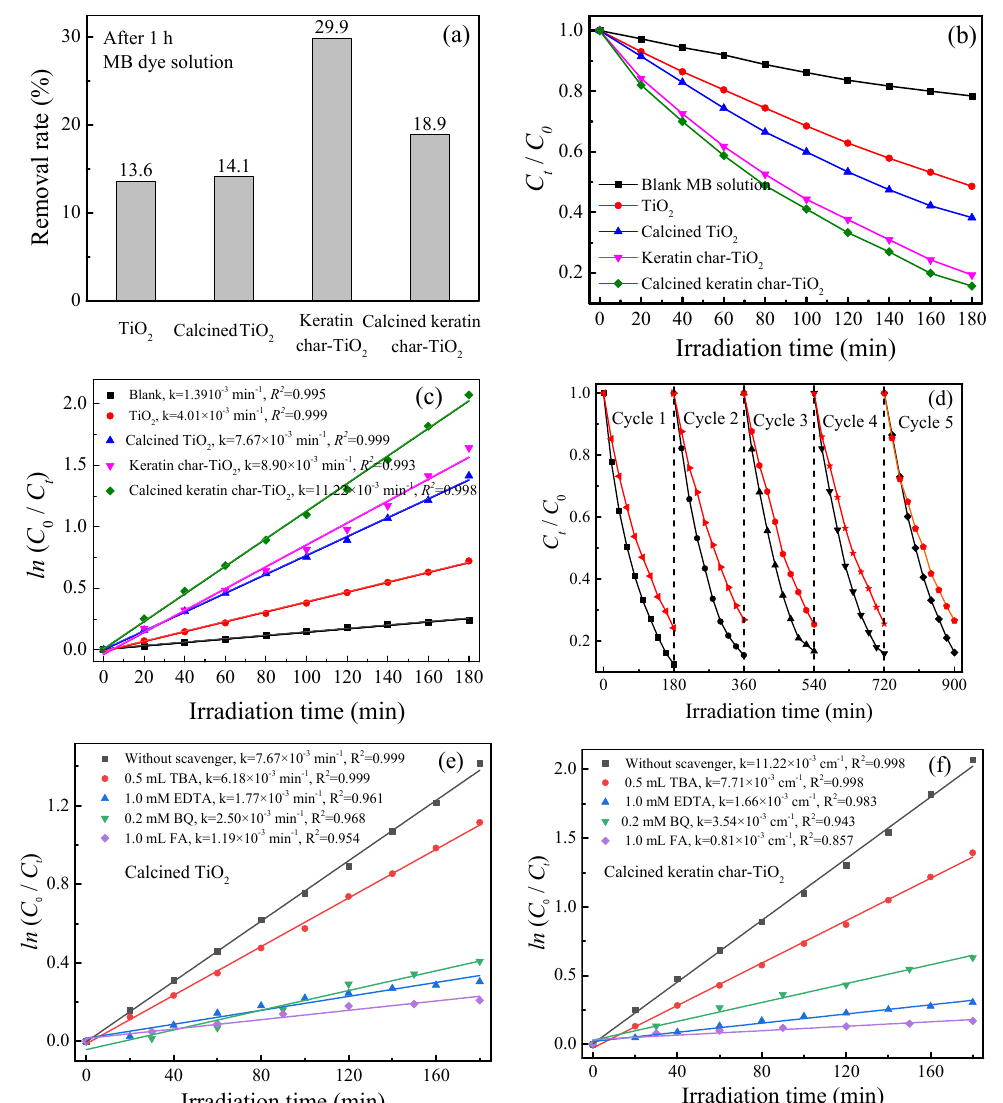
Figure 9. The ( a ) removal rate of MB dye, ( b ) photocatalytic degradation and ( c ) pseudo-first-order kinetic fitting of MB dye solution by the TiO 2 films and keratin char-TiO 2 composite films; ( d ) cycle photocatalytic degradation of MB dye solution by the calcined TiO 2 film and calcined keratin char-TiO 2 composite film, and trapping experiments for the photodegradation of MB dye solution by the calcined ( e ) TiO 2 film and ( f ) keratin char-TiO 2 composite film under visible light irradiation.